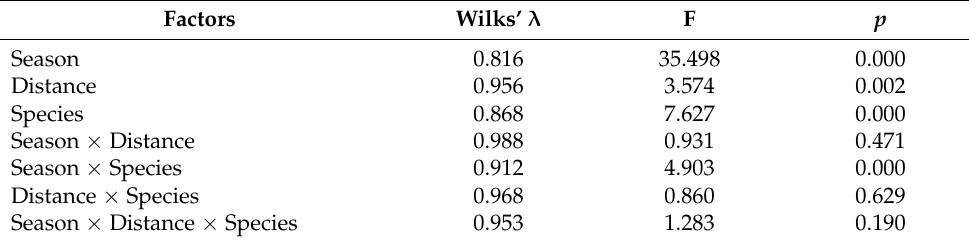
Table 2. Factors determining the diet of the carnivore community of the study area. Results of the MANOVA on the effects of species, season and distance to the road, and their interactions, on the position on the three axes of the multidimensional scaling that summarize scat contents.